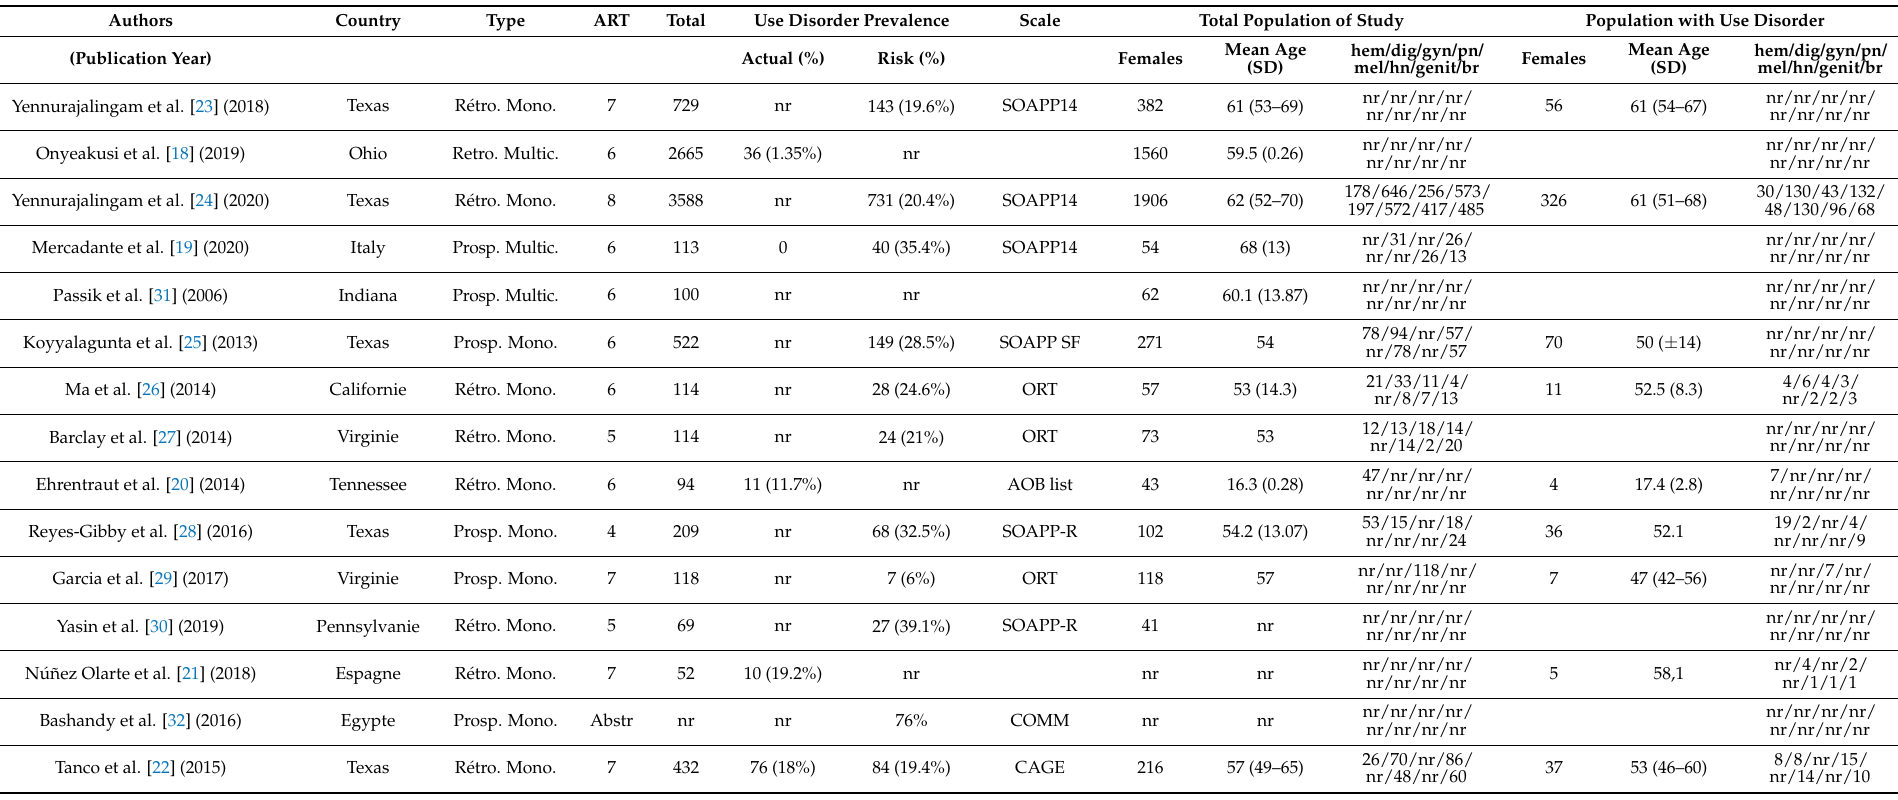
Table 1. Characteristics of studies included in the